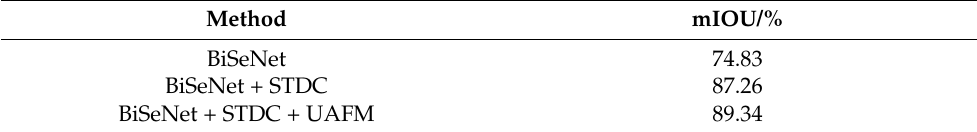
Table 3. Comparison of the effect of replacing the backbone network and adding